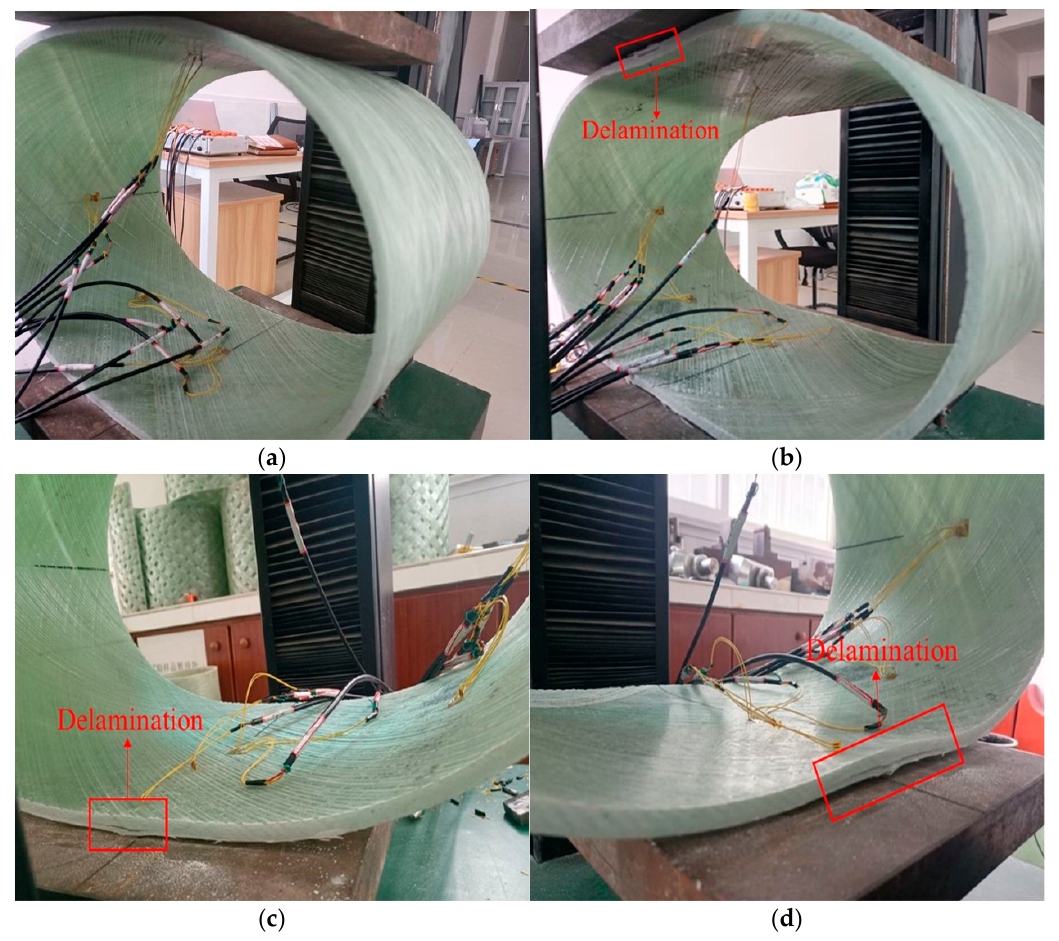
Figure 17. Deformation of inner stiffened pipes within failure phase: ( a ) 3% diametric deflections; ( b ) 15% diametric deflections; ( c ) 20% diametric deflections; ( d ) 30% diametric deflections.